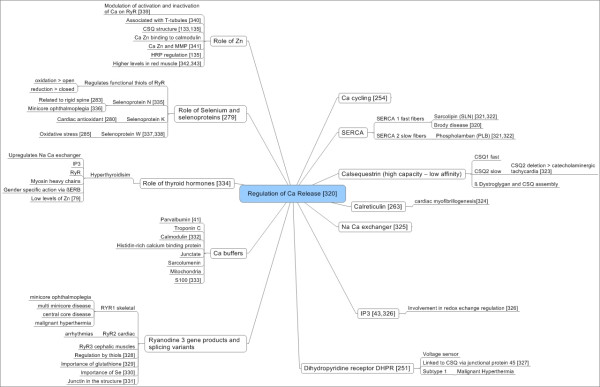
Graphical summary of relevant scientific data related to Ca regulation. Ca regulation has been suggested to be important in TAO. This assumption is based on the finding of antibodies directed against calsequestrin [40,370]. Interactions with Zn and Se are included.